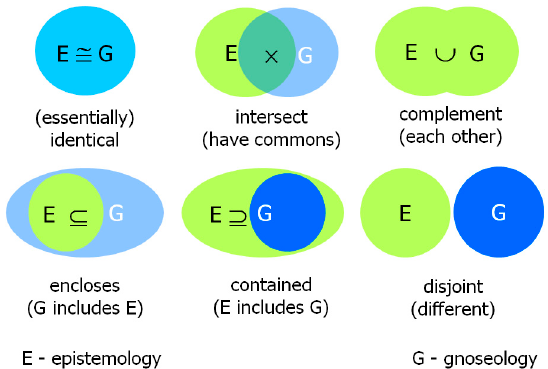
Figure 4. Conceivable relationships between gnoseology and epistemology.